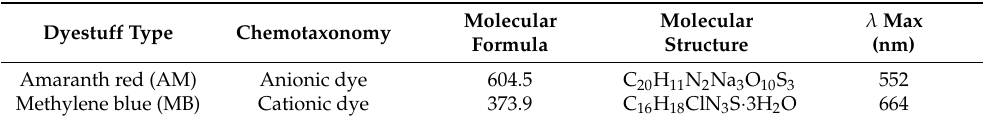
Table 2. Conventional property parameters of